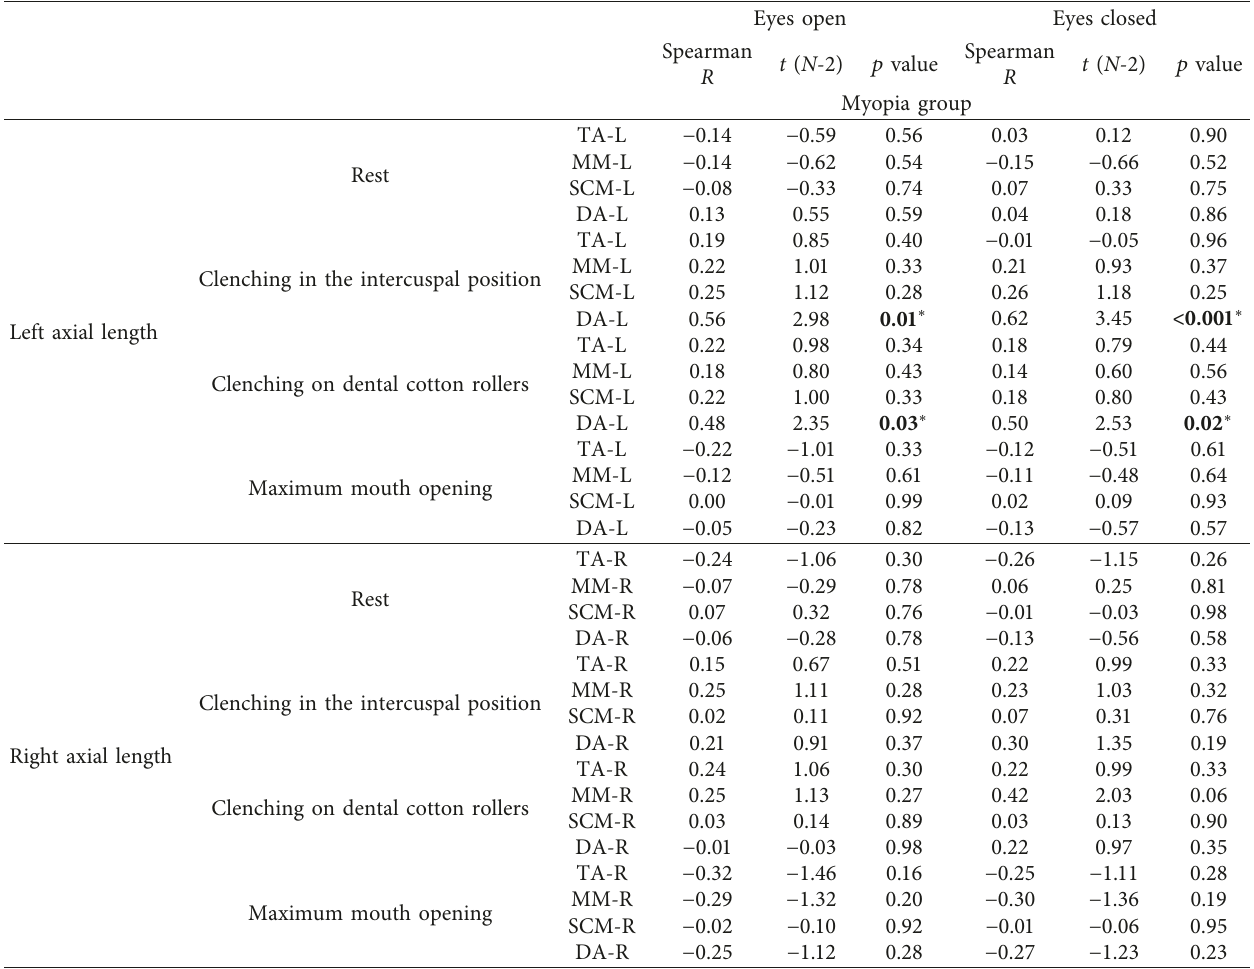
Table 3: Pooled correlation results in subjects with